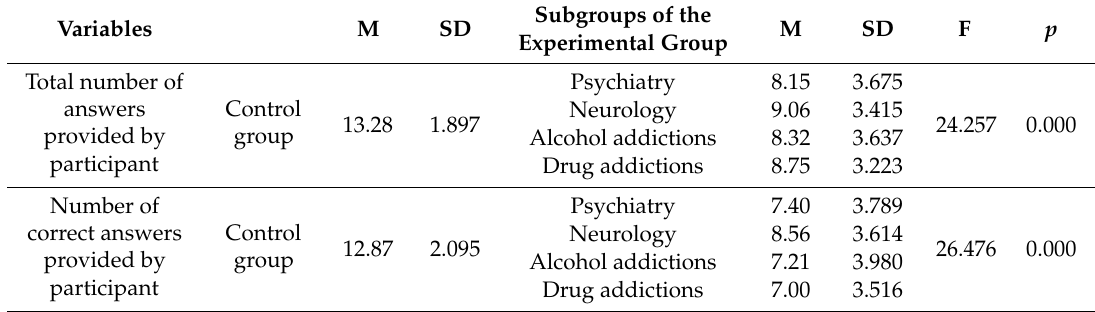
Table 5. Di ff erences in variables that distinguish executive functions in the control group and subgroups of the experimental